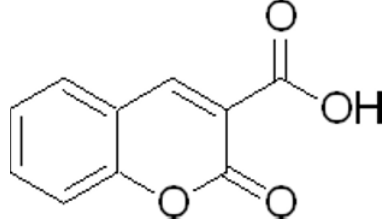
Figure 1. The structure of coumarin-3-carboxylic acid,